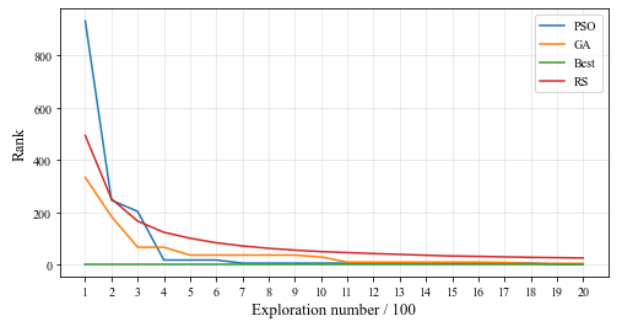
Figure 9. PMU placement ranking based on number of exploration—69-bus system, N m = 3.